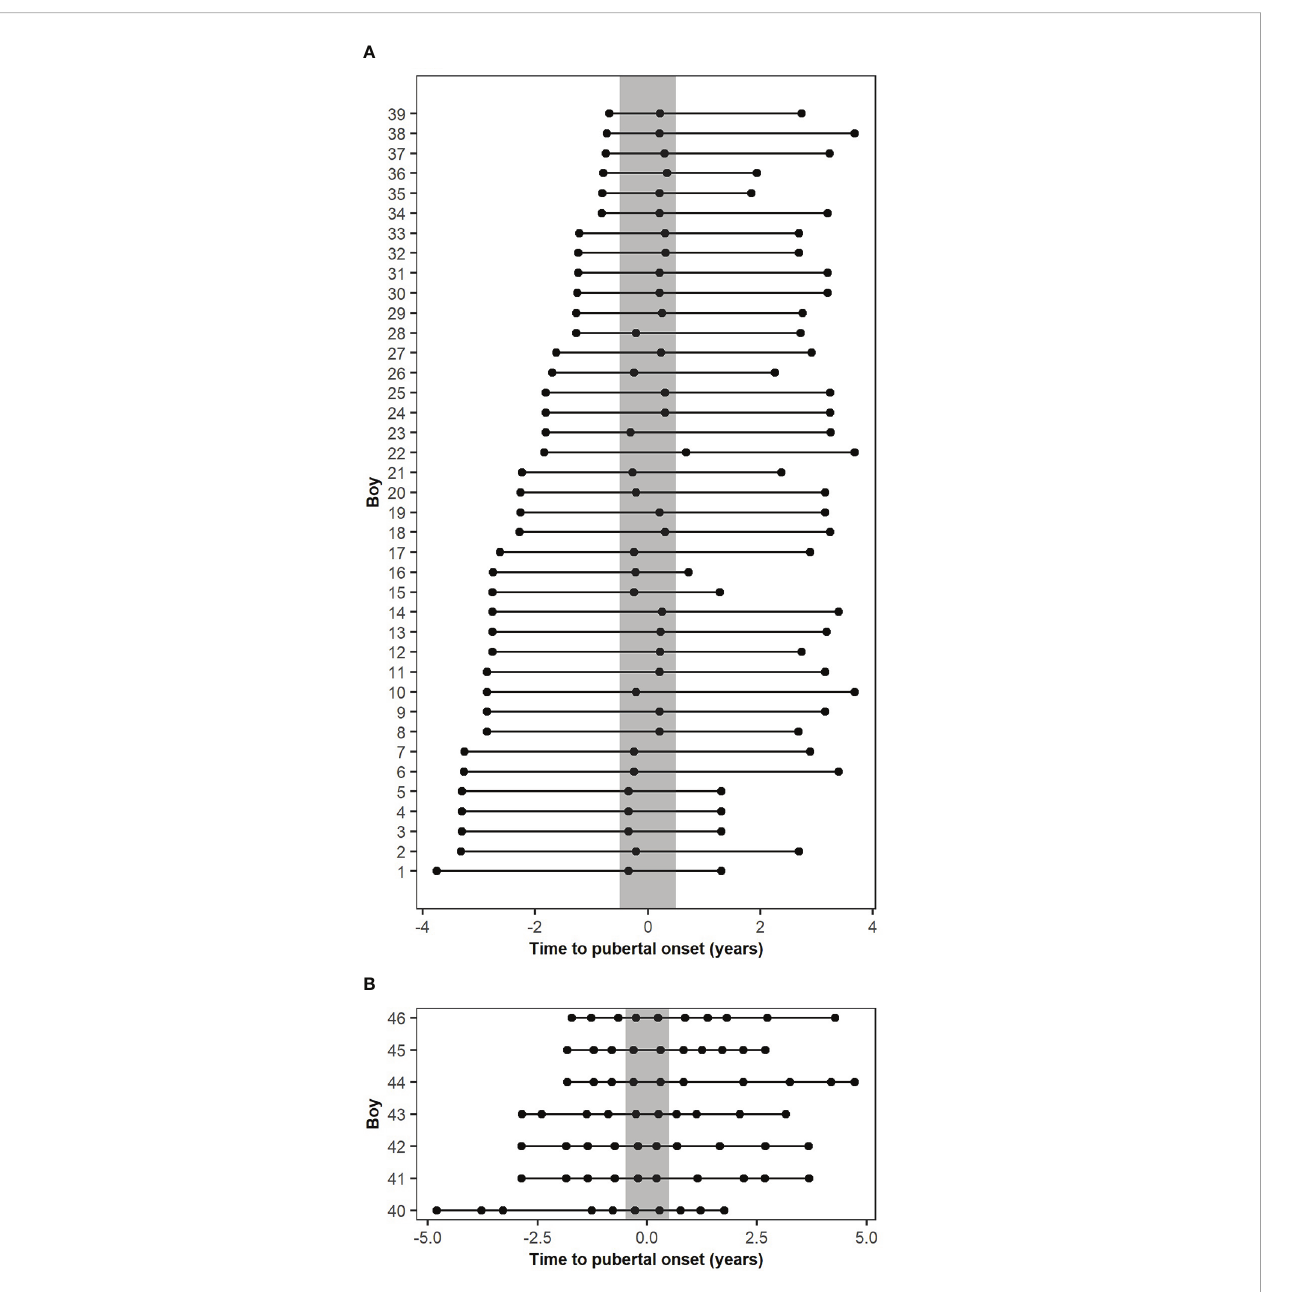
FIGURE 1 Descriptive fi gure of the timing of blood sampling according to the pubertal onset of the included cohorts. (A) Blood sample timing according to the pubertal onset of the main cohort. (B) Blood sample timing according to the pubertal onset of the extended cohort. The grey bar represents pubertal onset +/- 0.5